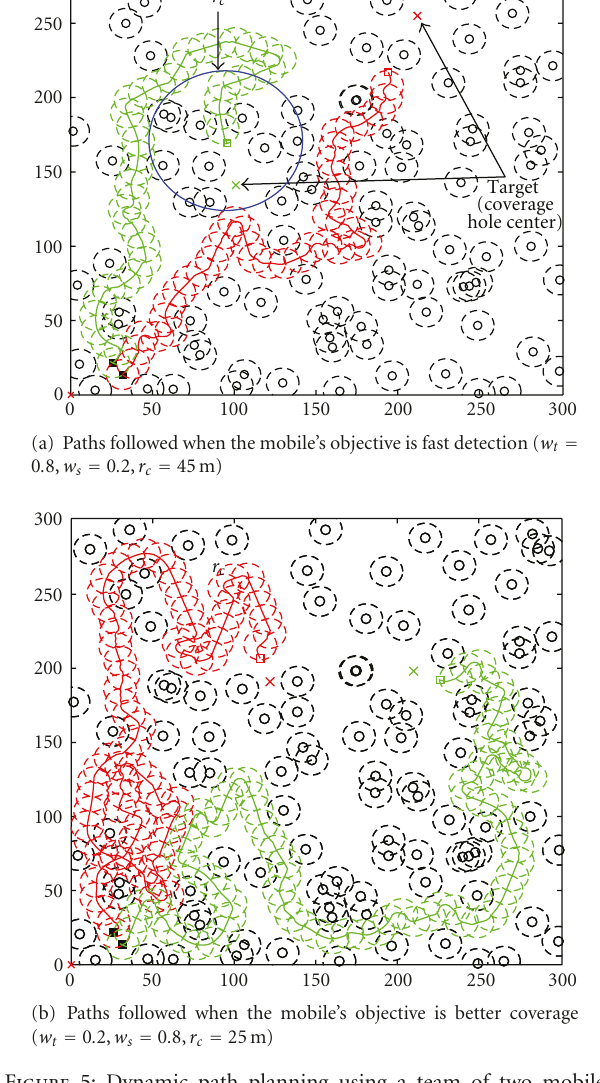
Figure 5: Dynamic path planning using a team of two mobile